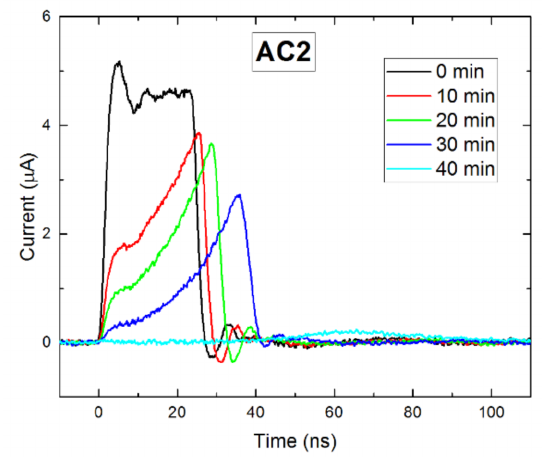
Figure 7. Time evolution of AC2 waveforms at 400 V bias.